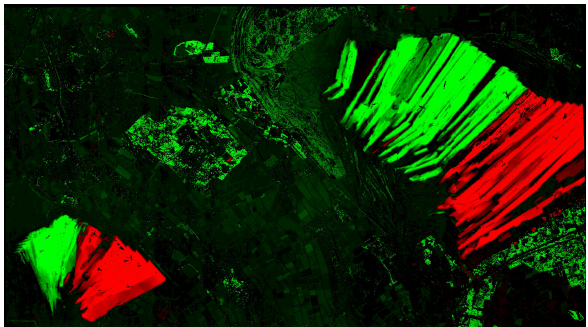
Figure 5: Volume changes between the WorldView-2 and GeoEye scene, 16 km × 9 km, red: negative changes, green: positive changes (0–60 m)